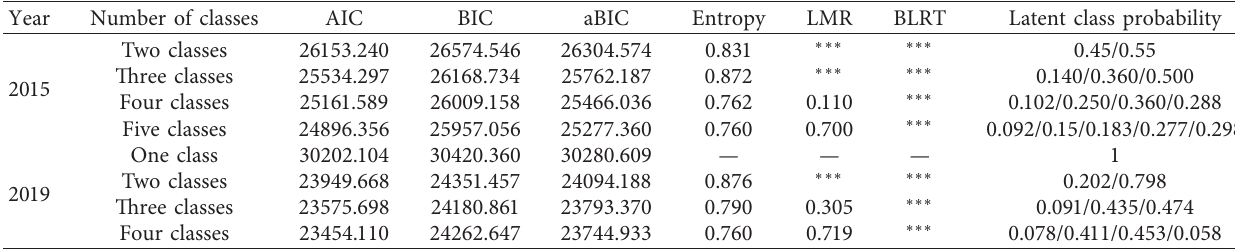
Table 6: Goodness-of-fit indices of LCA (2015 and 2019